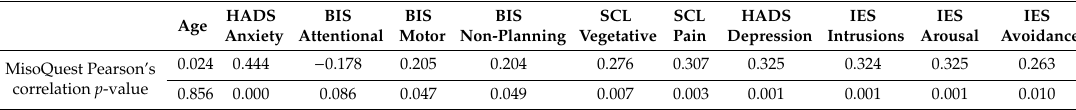
Table 2. Correlations with severity of misophonia symptoms assessed with